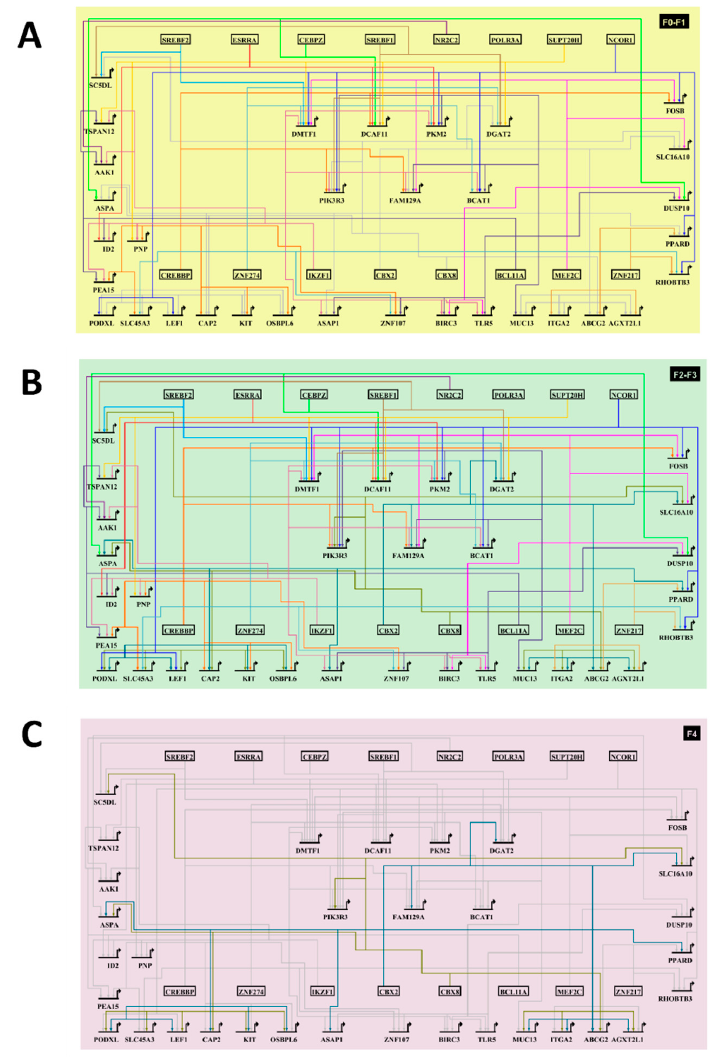
Figure 7. The HCC-AILD associated common gene regulatory network in F0–F1 stage ( A ), F2–F3 stage ( B ) and F4 stage ( C ). Genes in the center are hub genes, having at least four links to the transcription factors (shown in the boxes). All networks are constructed on BioTapestry